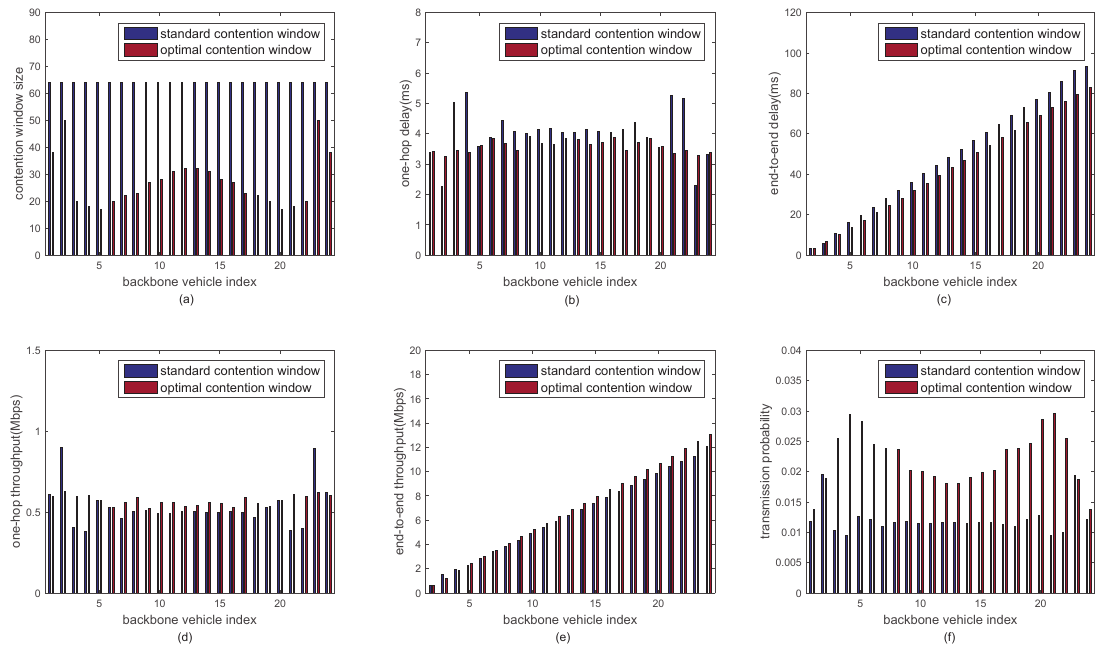
Figure 7. The performance of inter-platoon communications under 24 backbone vehicles. ( a ) Minimum contention window size vs backbone vehicle index; ( b ) One-hop delay vs backbone vehicle index; ( c ) End-to-end delay vs backbone vehicle index; ( d ) One-hop throughput vs backbone vehicle index; ( e ) End-to-end throughput vs backbone vehicle index; ( f ) Transmission probability vs backbone vehicle